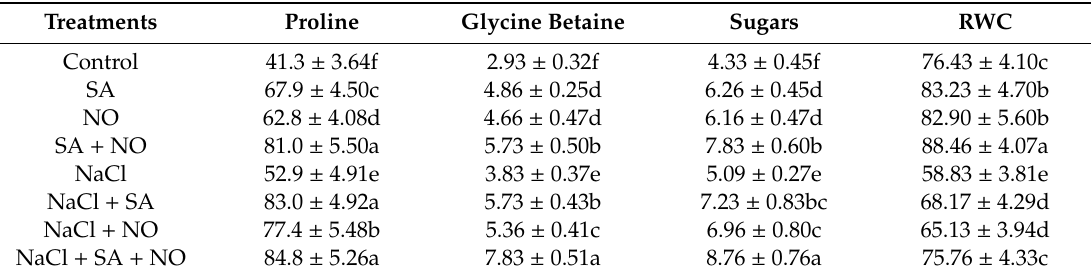
Table 2. E ff ect of exogenous application of SA and NO on proline, glycine betaine, sugars and relative water content in Vigna angularis under salinity (100 mM NaCl) stress. Data are the mean of four replicates and di ff erent letters show significant di ff erence at p < 0.05. Proline Glycine Betaine